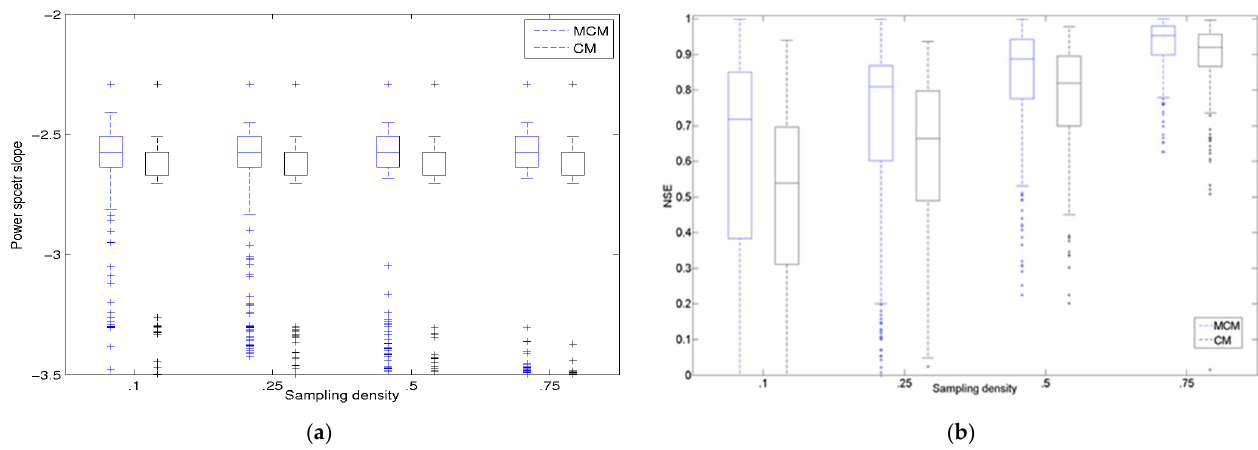
Figure 7. Ensemble of power spectra slope mean along x directions of the interpolators ( a ) and NSE ( b ), varying with the density. The blue lines indicate MCM, while the black ones indicate CM.